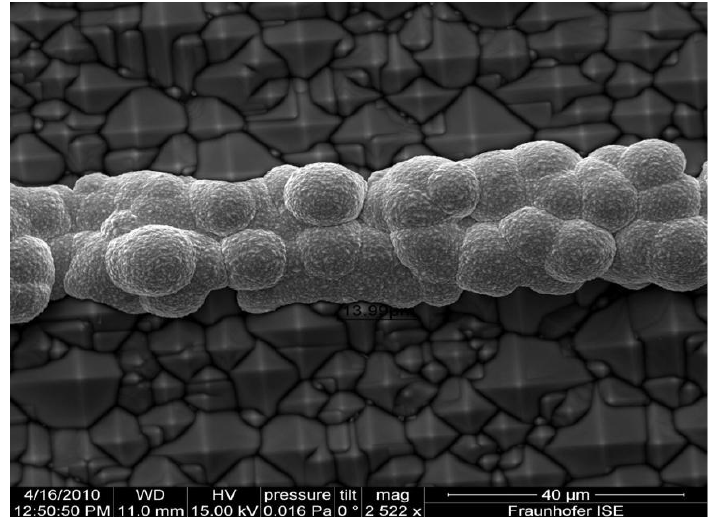
Figure 5. Plating of Ni by electrochemical deposition done by Mondon et al. at Fraunhofer ISE and presented at the 2nd metallization workshop for crystalline silicon solar cells, reprinted with permission from the authors (2014) [49].